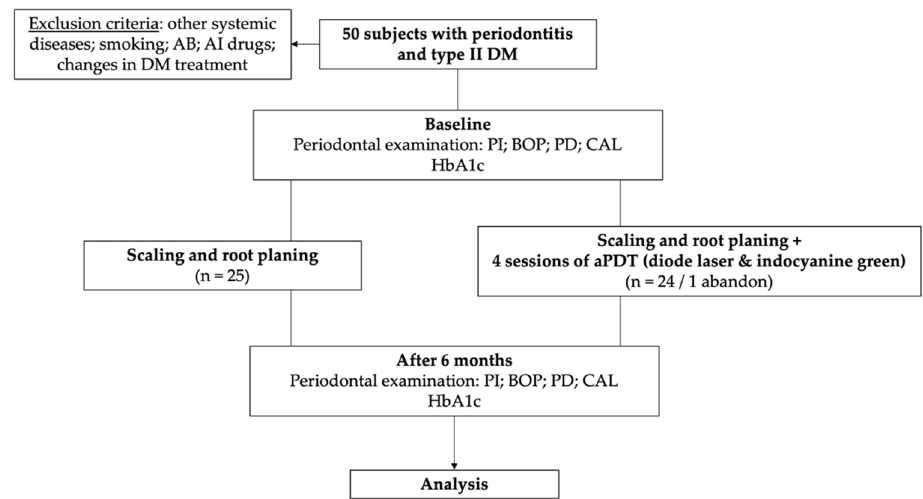
Figure 1. The flowchart of the study.